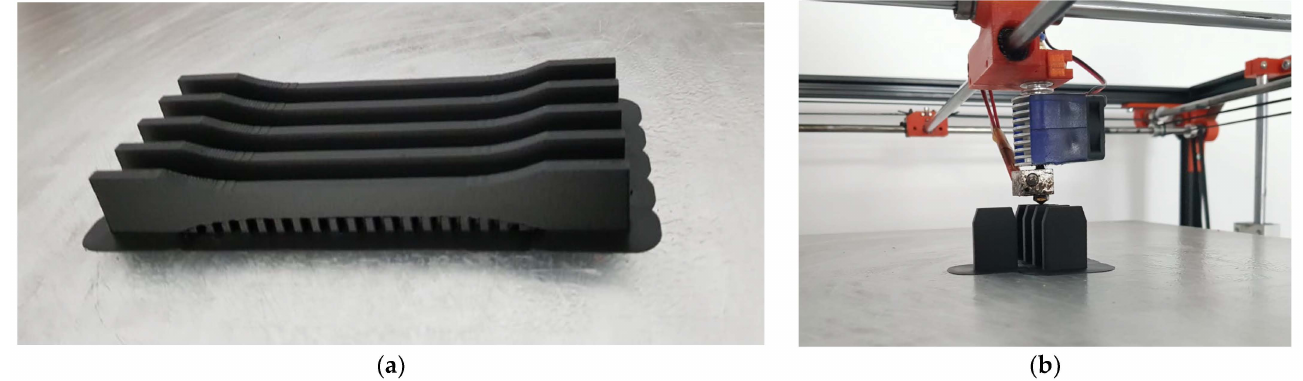
Figure 3. Different phases in the manufacturing process: ( a ) Tensile specimens printed on the lateral side, with over hangings; ( b ) Tensile test specimens printed along the vertical direction.